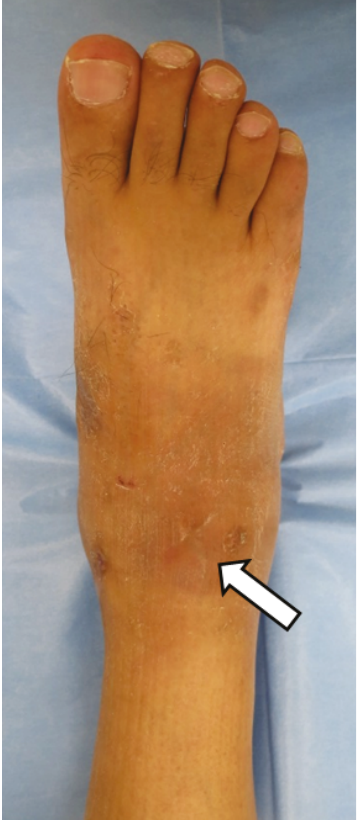
Figure 2: Photograph of the ankle and foot showing swelling around the anterolateral portal (arrow) 4 weeks after ankle